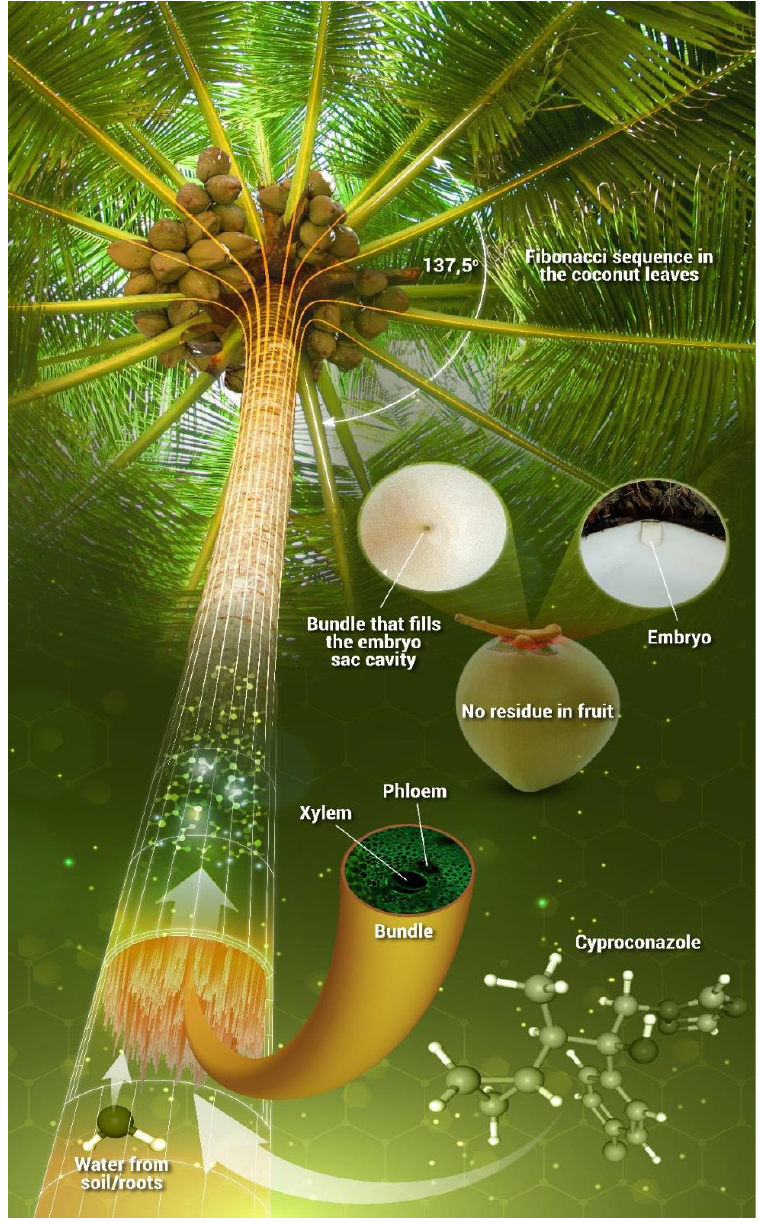
Figure 5. Scheme of the application of cyproconazole to coconut palm, showing translocation through the vascular bundles following the flow of sap from the roots/soil to the leaves, without contamination of the fruit.